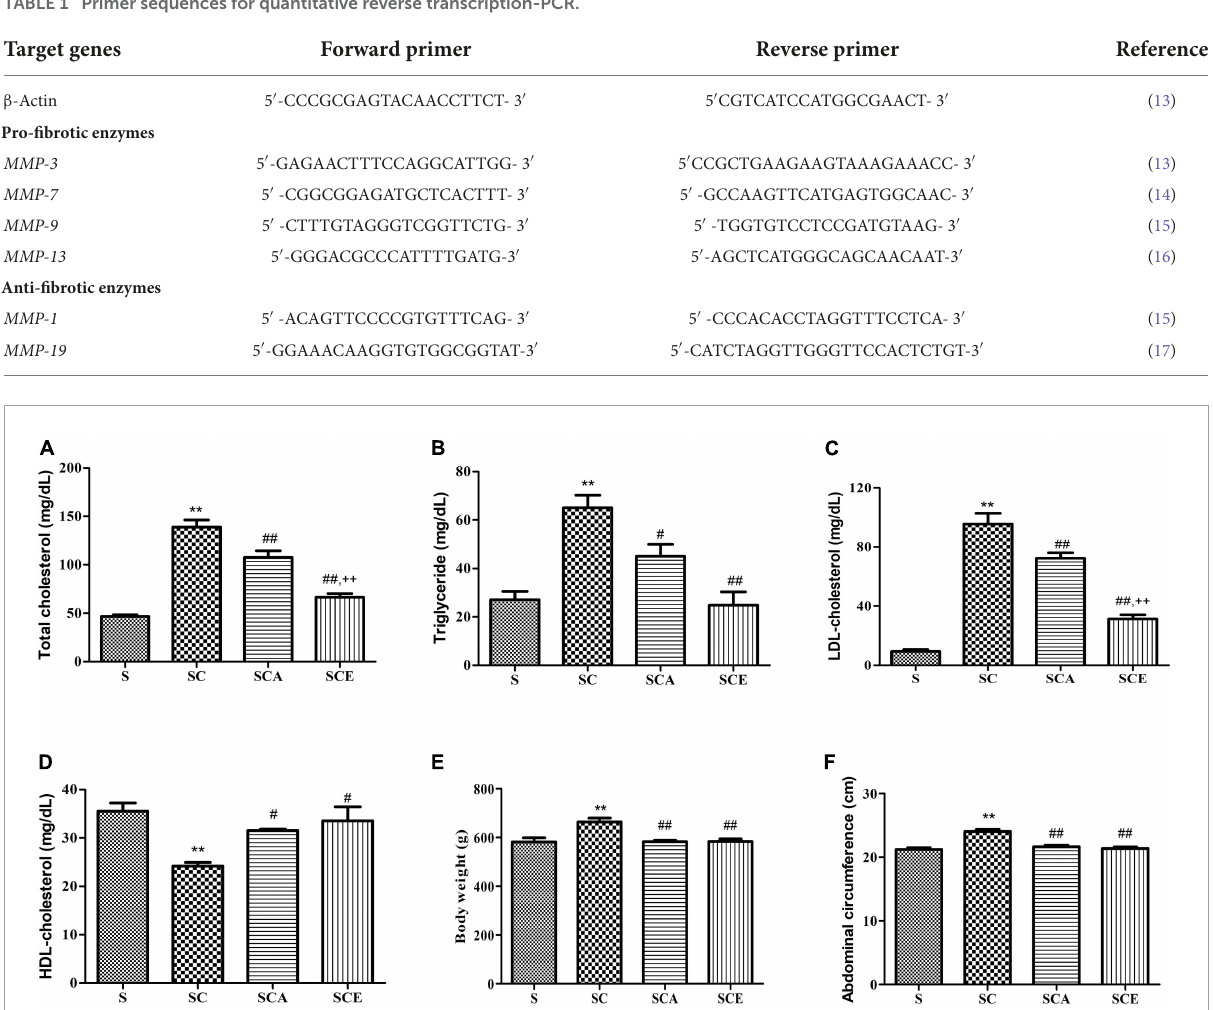
FIGURE1 Effects of atorvastatin and ezetimibe treatment on lipid parameters and model characteristics in hypercholesterolemic rats. (A) Total cholesterol (TC); (B) triglyceride (TG); (C) LDL-cholesterol (LDL-C); (D) HDL-cholesterol (HDL-C); (E) body weight (BW) and (F) abdominal circumference (AC). Data are presented as mean ± SEM. ** p < 0.01 vs. the control group; # p < 0.05; ## p < 0.01 vs. the SC group; ++ p < 0.01 vs. the SCA group ( n = 6 per